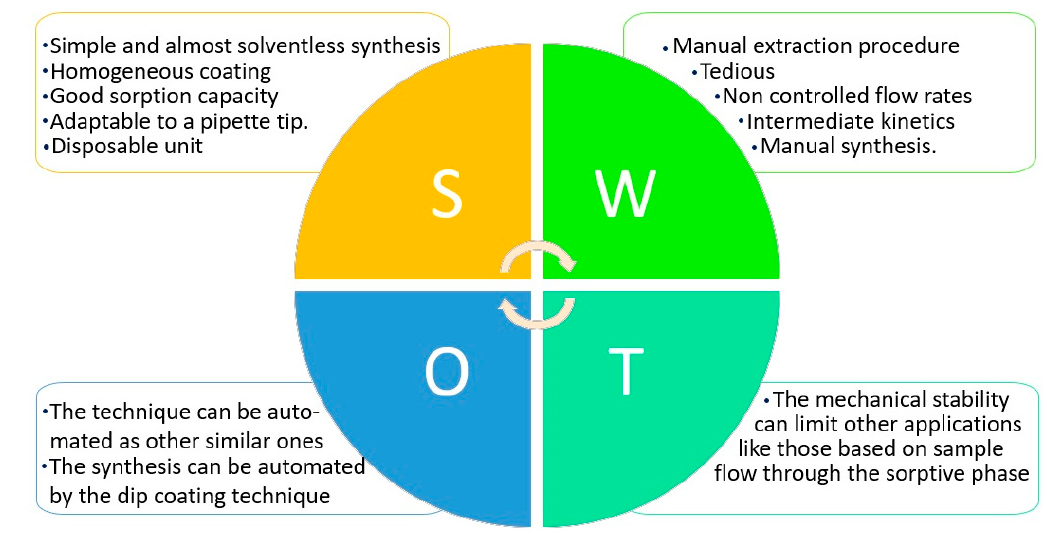
Figure 5. SWOT (Strengths, Weaknesses, Opportunities, and Threats) analysis of the new sorptive phase.